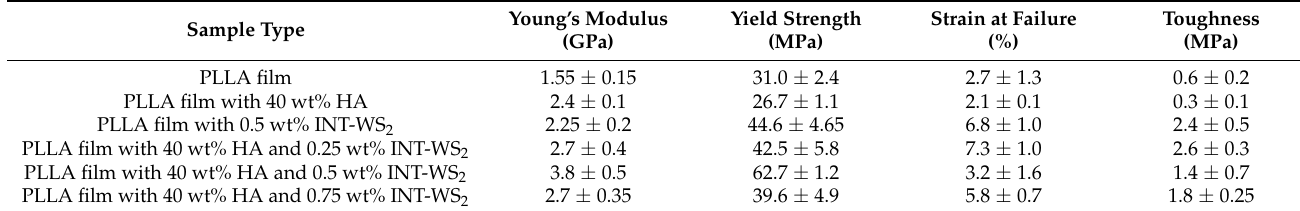
Figure 6. Stress–strain curves of PLLA film and its HA/INT-WS 2 /PLLA nanocomposites. Table 2. The mechanical properties of PLLA film and HA/INT-WS 2 /PLLA nanocomposites from tensile testing. Sample